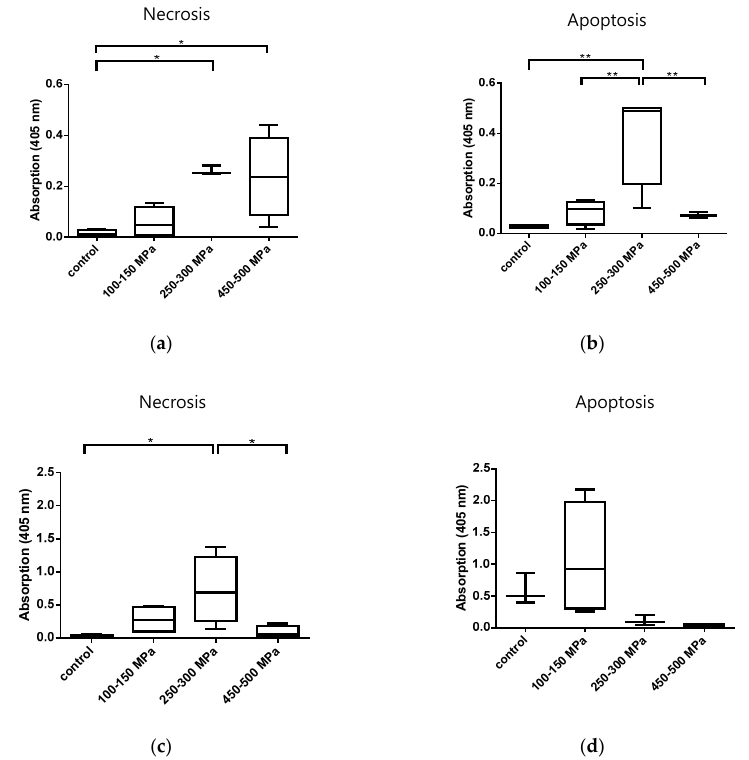
Figure 2. Analysis of cell death induced by HHP treatment of ( a ) and ( b ) human osteoblasts ( n = 4), and ( c ) and ( d ) human chondrocytes ( n = 4). Graphics ( a ) and ( c ) show necrosis and graphics ( b ) and ( d ) show apoptosis, both detected via Cell Death Detection ELISA. After HHP treatment, the supernatants were collected for necrosis detection. The residual cells were lysed for 30 min with 200 µL lysis buffer provided by the kit. After centrifugation at 118× g for 8 min, supernatants were collected for apoptosis detection. All data are presented as boxplots. Significant differences between groups were determined via one-way ANOVA. * p ≤ 0.05; ** p ≤ 0.01.